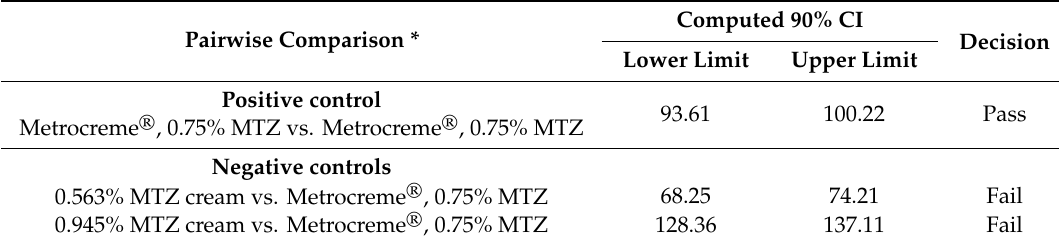
Table 6. Computed 90% CI for negative and positive controls used to assess discriminatory power of the IVRT